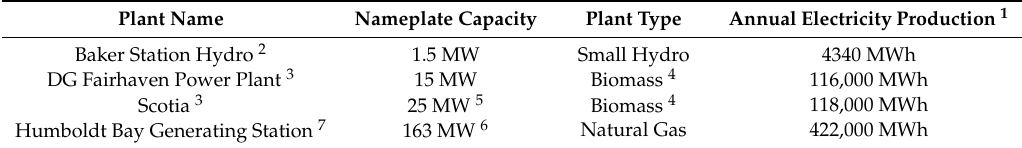
Table 1. Humboldt County generation resources.